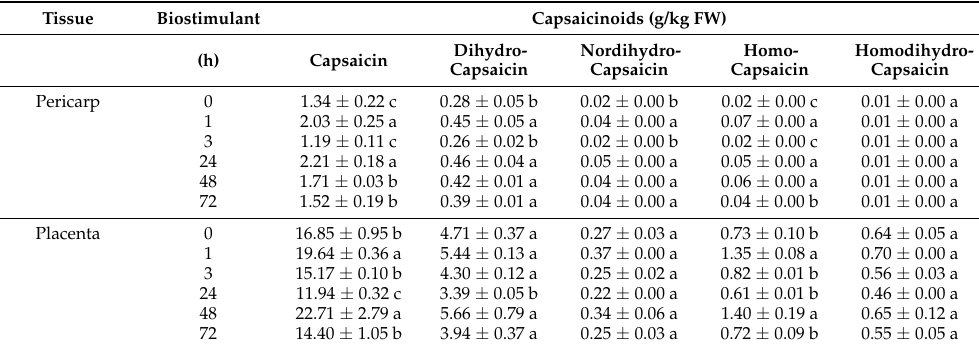
Table 1. Individual capsaicinoids identified in the chili fruit pericarp and placenta before and after biostimulant application (mean ±